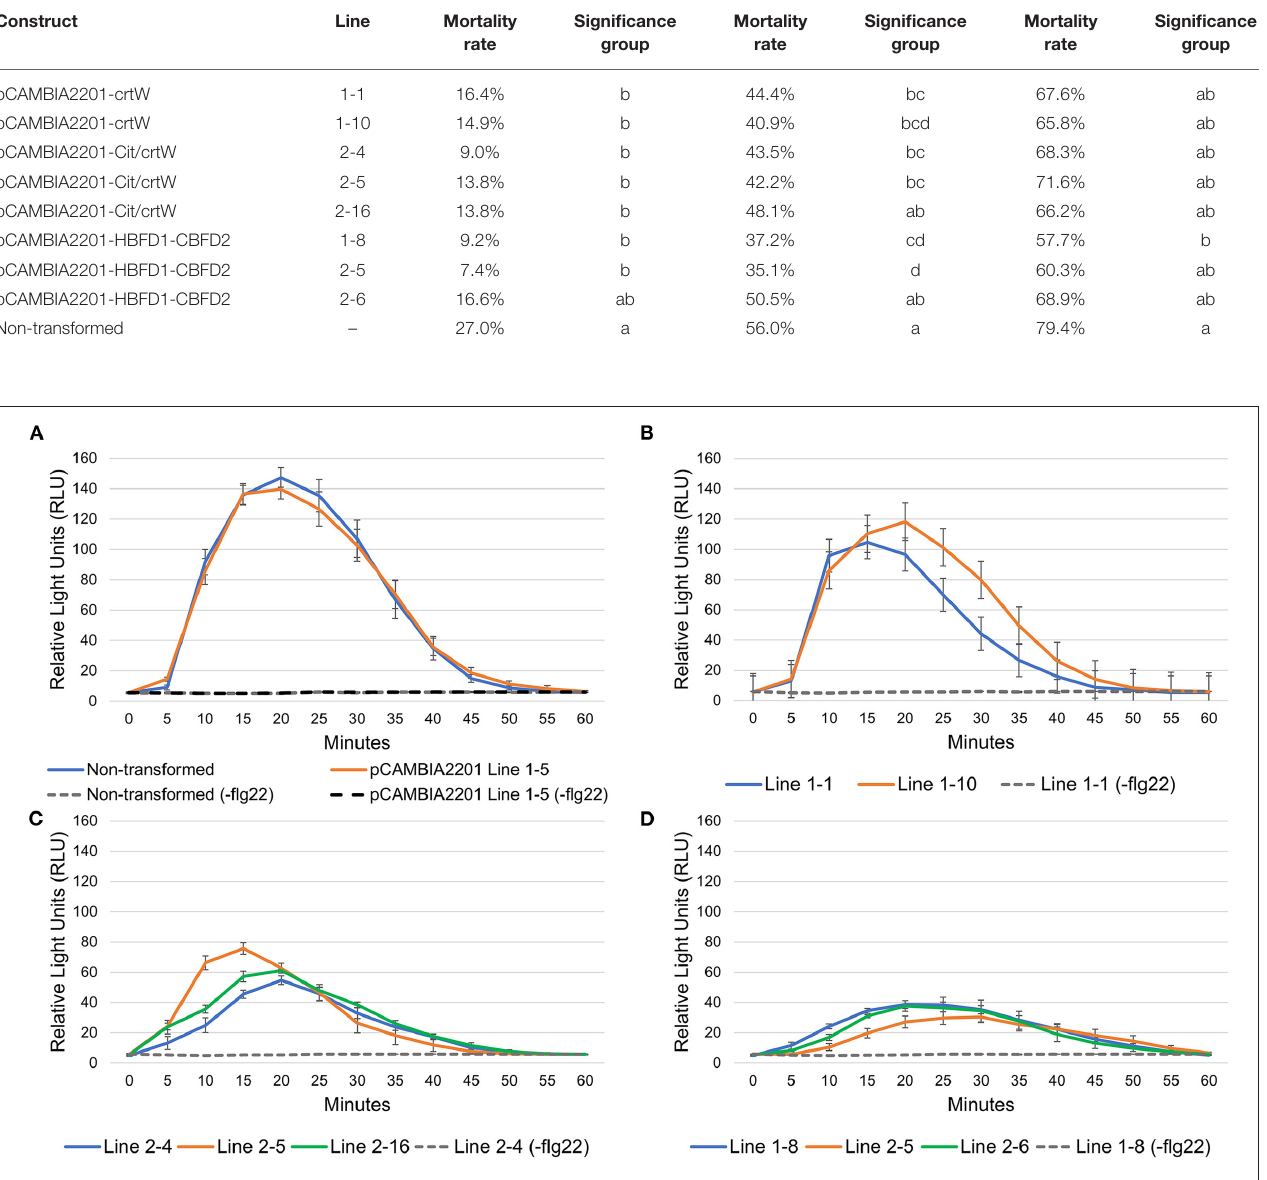
FIGURE 4 | Flg22-triggered oxidative burst assays in T1 N. benthamiana leaf disks. The luminescence readings are from (A) empty vector and non-transformed control plants, (B) plants expressing crtW, (C) plants expressing Cit/crtW, and (D) plants expressing HBFD1-CBFD2. Assay solution containing 500nM flg22 was added to the leaf disks at 0min and luminescence measurements started immediately. For each sample analyzed, a control sample was included containing no flg22 (-flg22) in the assay mix, which is represented by the dashed lines on each